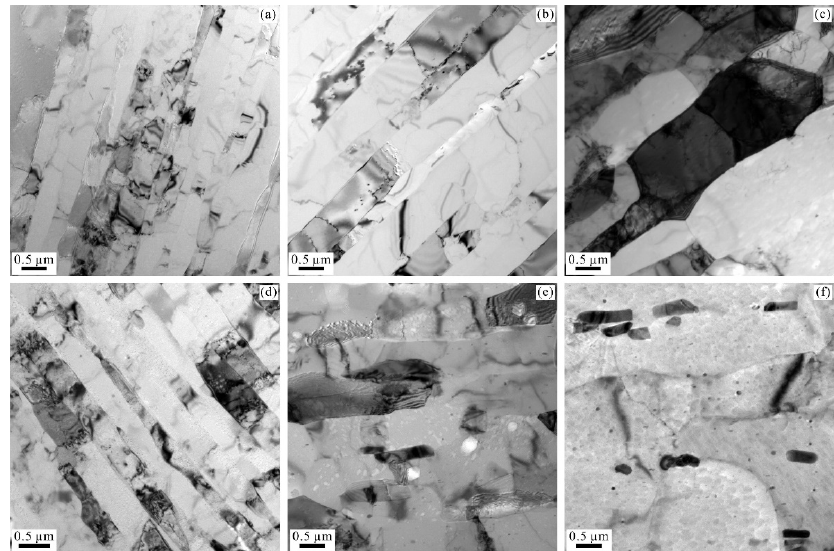
Figure 4. The axial microstructures observed by TEM of ( a ) the cold-drawn CPAW, ( b ) the CPAW annealed at 90 ◦ C for 8 h, ( c ) the CPAW annealed at 250 ◦ C for 8 h, ( d ) the cold-drawn AFW, ( e ) the AFW annealed at 200 ◦ C for 8 h, ( f ) the AFW annealed at 250 ◦ C for 8 h.